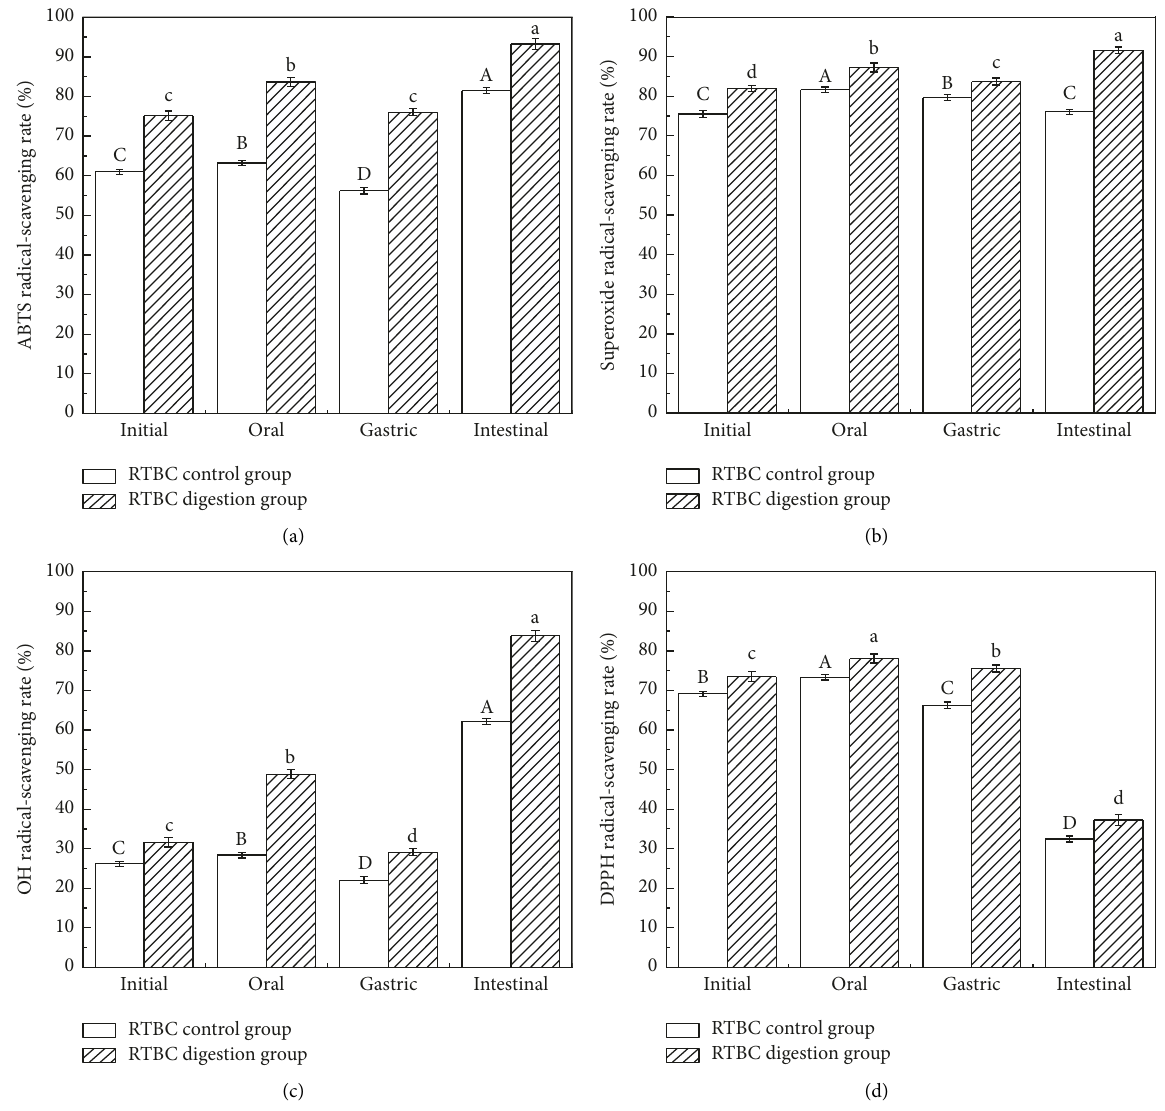
Figure 2: Effect of antioxidant activity of the RTBC in vitro digestion. Data are expressed as the mean ± standard deviation ( n � 3). (a–d) Different lowercase letters represent significant different among digestion groups. (A–D) Different uppercase letters represent the significant different among the control groups ( P < 0 .